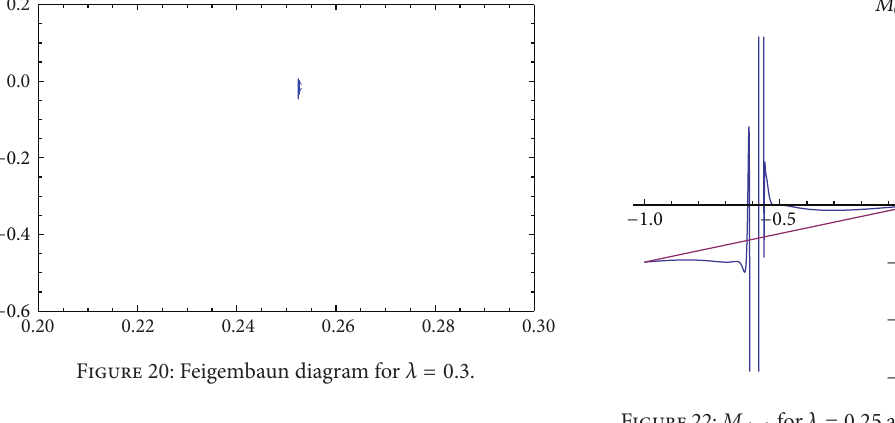
Figure 20: Feigembaun diagram for 𝜆 = 0.3 .